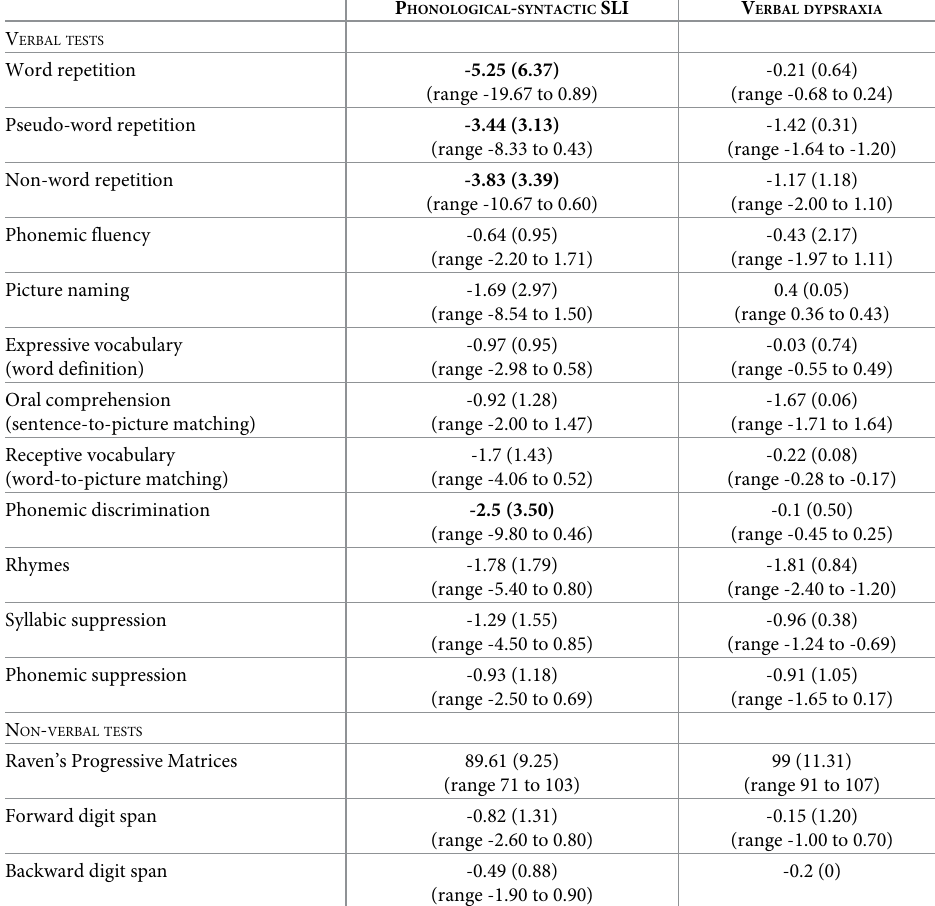
Table 1. Verbal and non-verbal abilities of children with SLI as assessed by standardized neuropsychological